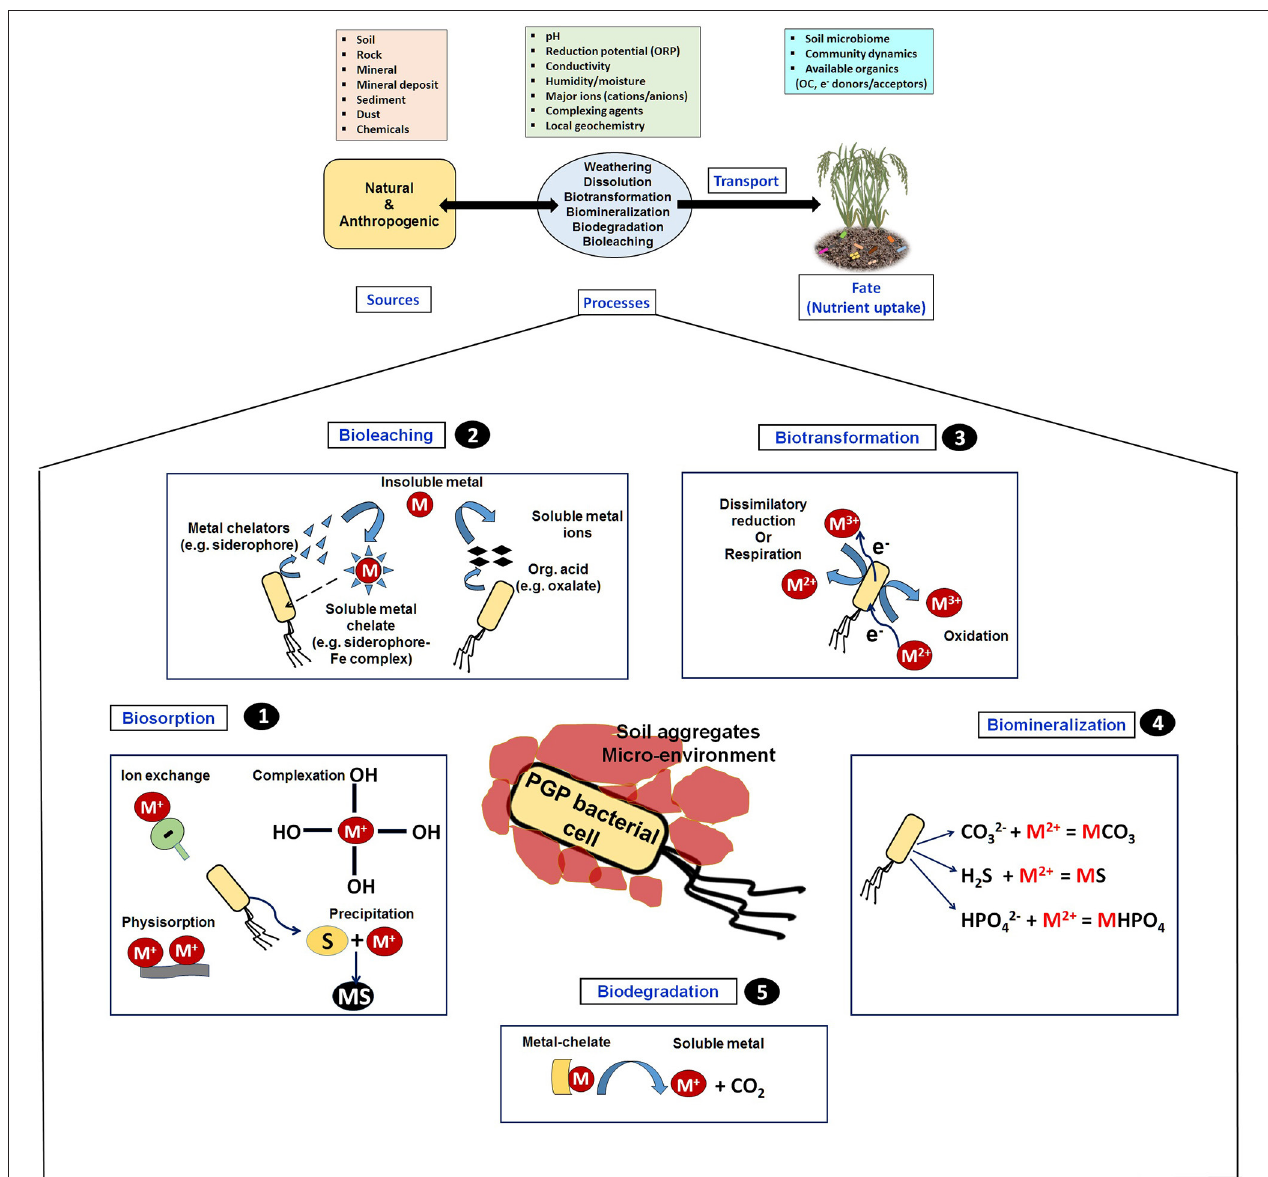
FIGURE 4 | Geochemical pathways involving sources, processes, and transport factors influencing the fate of nutrient availability at soil solution and its uptake by plants (upper panel) and diverse types of geomicrobiological interactions that occur between microbe and solid mineral phase for metal (Fe, P, K) solubilization (lower panel in pentagon